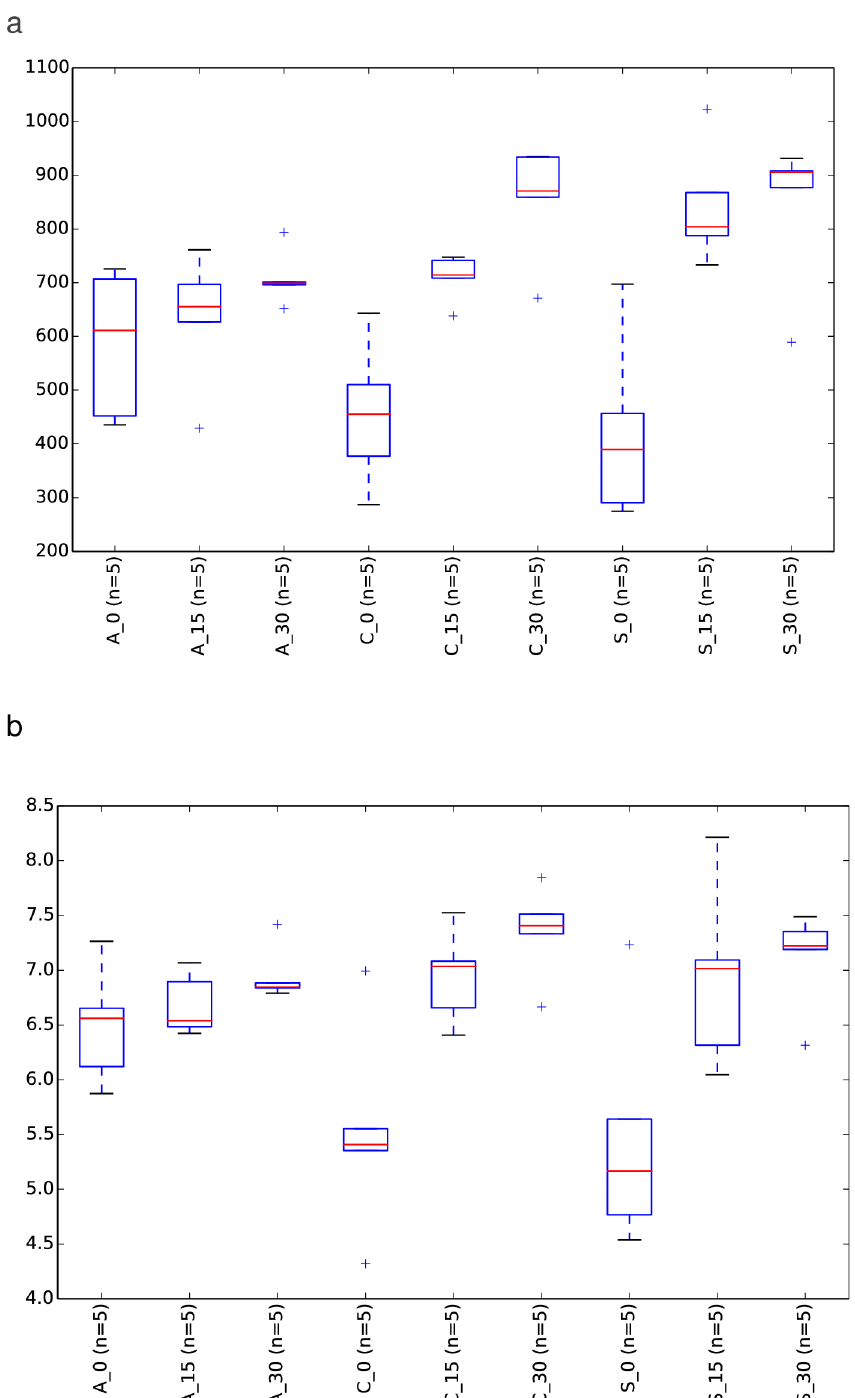
Fig 6. Alpha diversity on samples analyzed by experimental group and time point. Alpha diversity was compared between groups by measuring different metrics: Observed species (a) and Shannon Index (b). X_Y means experimental (control-C, feed additive- S, antibiotic-A,) and day group (0, 15 and 30), respectively.